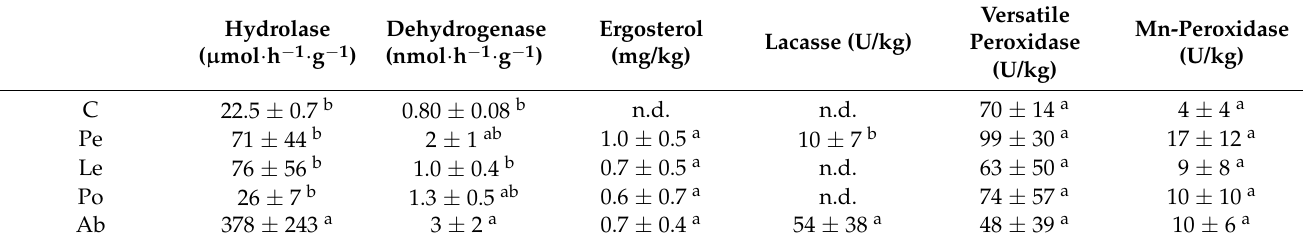
Table 2. Enzymatic activities (total hydrolase, dehydrogenase, laccase, versatile peroxidase, Mn- peroxidase) and ergosterol content of the control microcosms (C), and microcosms inoculated with SMS of P. eryngii (Pe), L. edodes (Le), P. ostreatus (Po) and A. bisporus (Ab) at the end of the incubation. Data are presented as mean values ± standard deviation ( n = 3). Same letters indicate lack of statistically significant difference ( p < 0.05) between treatments. n.d.: parameter not detected.